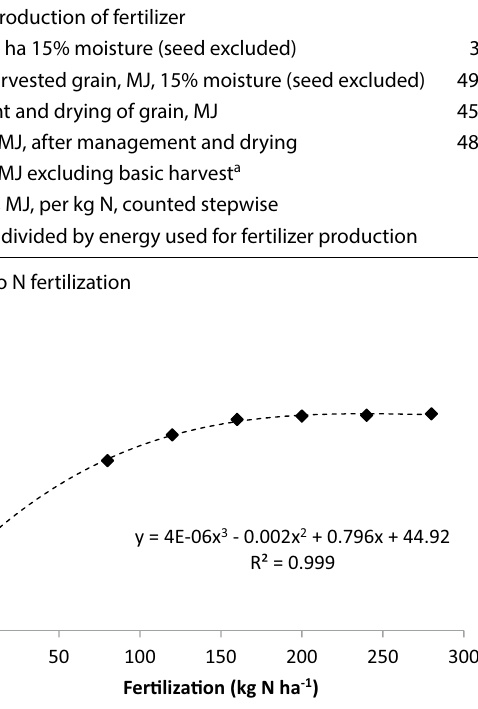
Fig. 6 Net energy binding (i.e., net energy gain, GJ ha −1 ) in winter wheat grown at different fertilization levels (kg N ha −1 ). Energy con- sumption in fertilizer production, cultivation, and drying of grain deducted. Straw is an additional bonus, i.e., it is not included in these